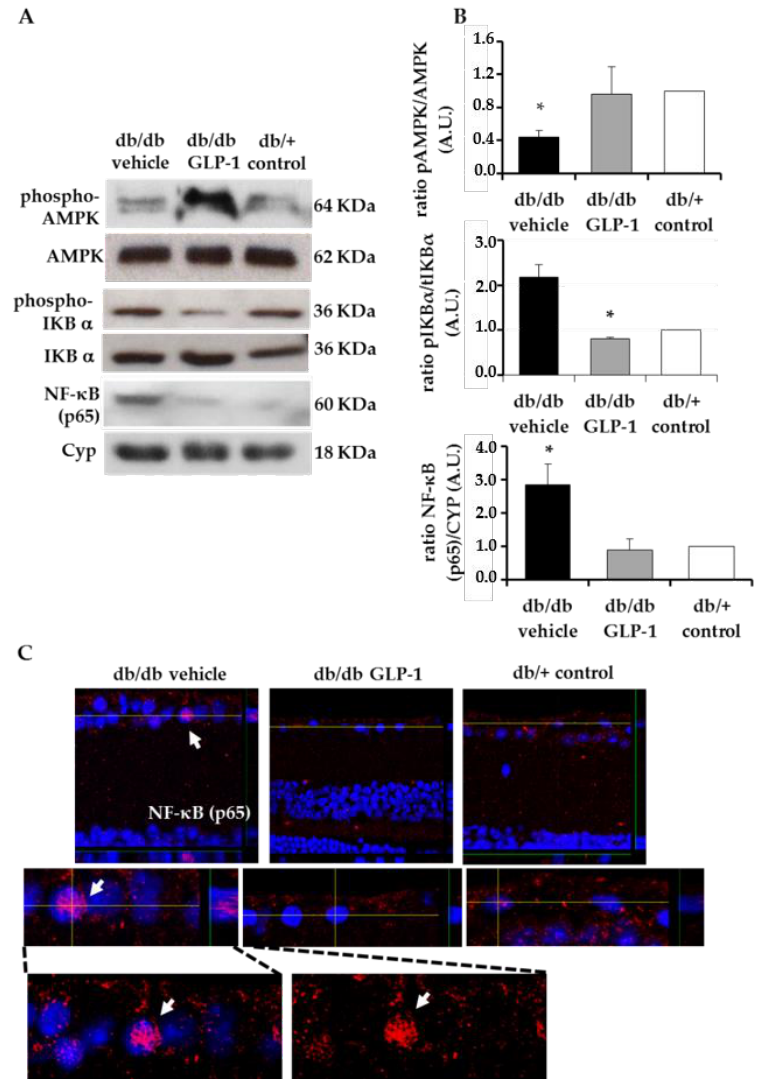
Figure 5. Anti-inflammatory effects. ( A ) Western blotting bands of phospho-AMPK, total AMPK, phospho-IKB α , total IKB α , NF- κ B (p65) and ( B ) densitometric analyses in mouse retinas in db/db mice treated with vehicle (black bars), db/db mice treated with glucagon-like peptide-1 (GLP-1) eye drops (grey bars) and non-diabetic mice (white bars) n = 4 * p < 0.05 db/db vehicle in comparison with other groups, ( C ) Orthogonal view of confocal images from NF-kB p65 in a representative db/db mouse treated with vehicle, a db/db mouse treated with GLP-1 eye-drops and a non-diabetic mouse by immunofluorescence. Red: NF-kB p65 antibody stained. Blue: Hoechst